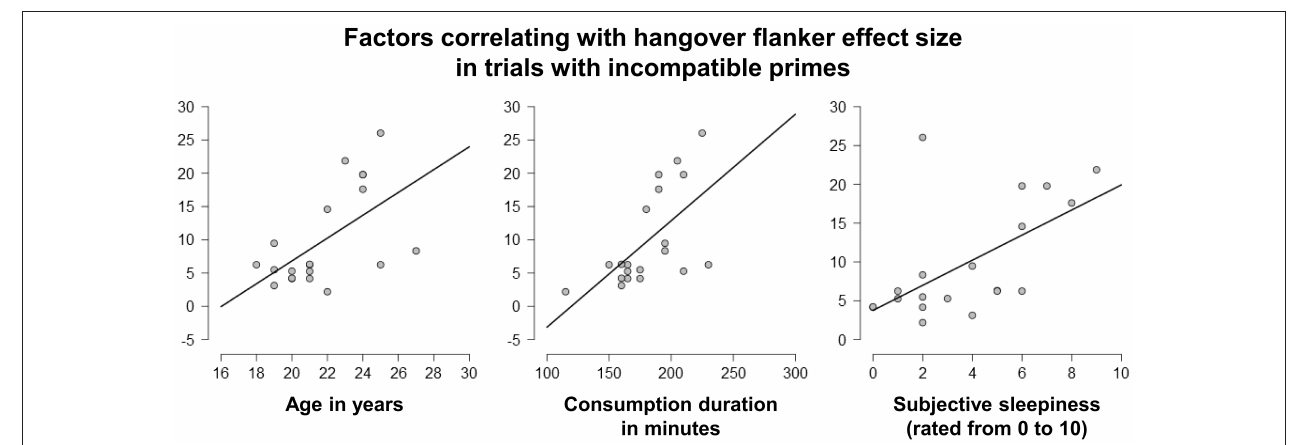
FIGURE 6 | Linear correlation analyses. The size of the flanker effect, which had been found to be increased by hangover when the subliminal primes were incompatible, was positively correlated with age (left) , consumption speed during intoxication induction (middle) , and subjective sleepiness during the hangover appointment (right) (all p < 0.010). It should however be noted that age and consumption speed were also positively